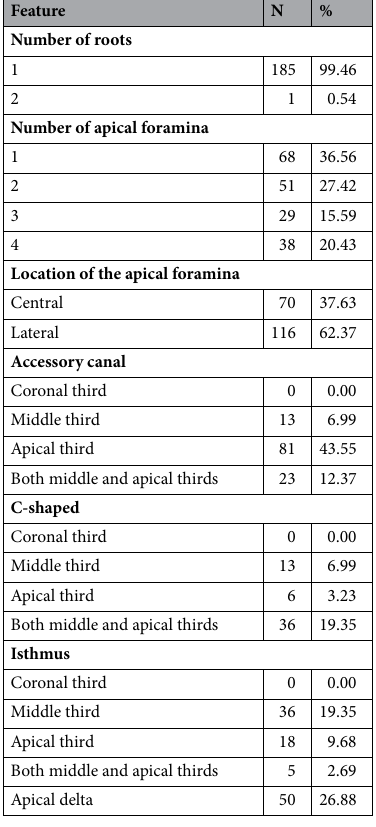
Table 5. General anatomical features of the analyzed